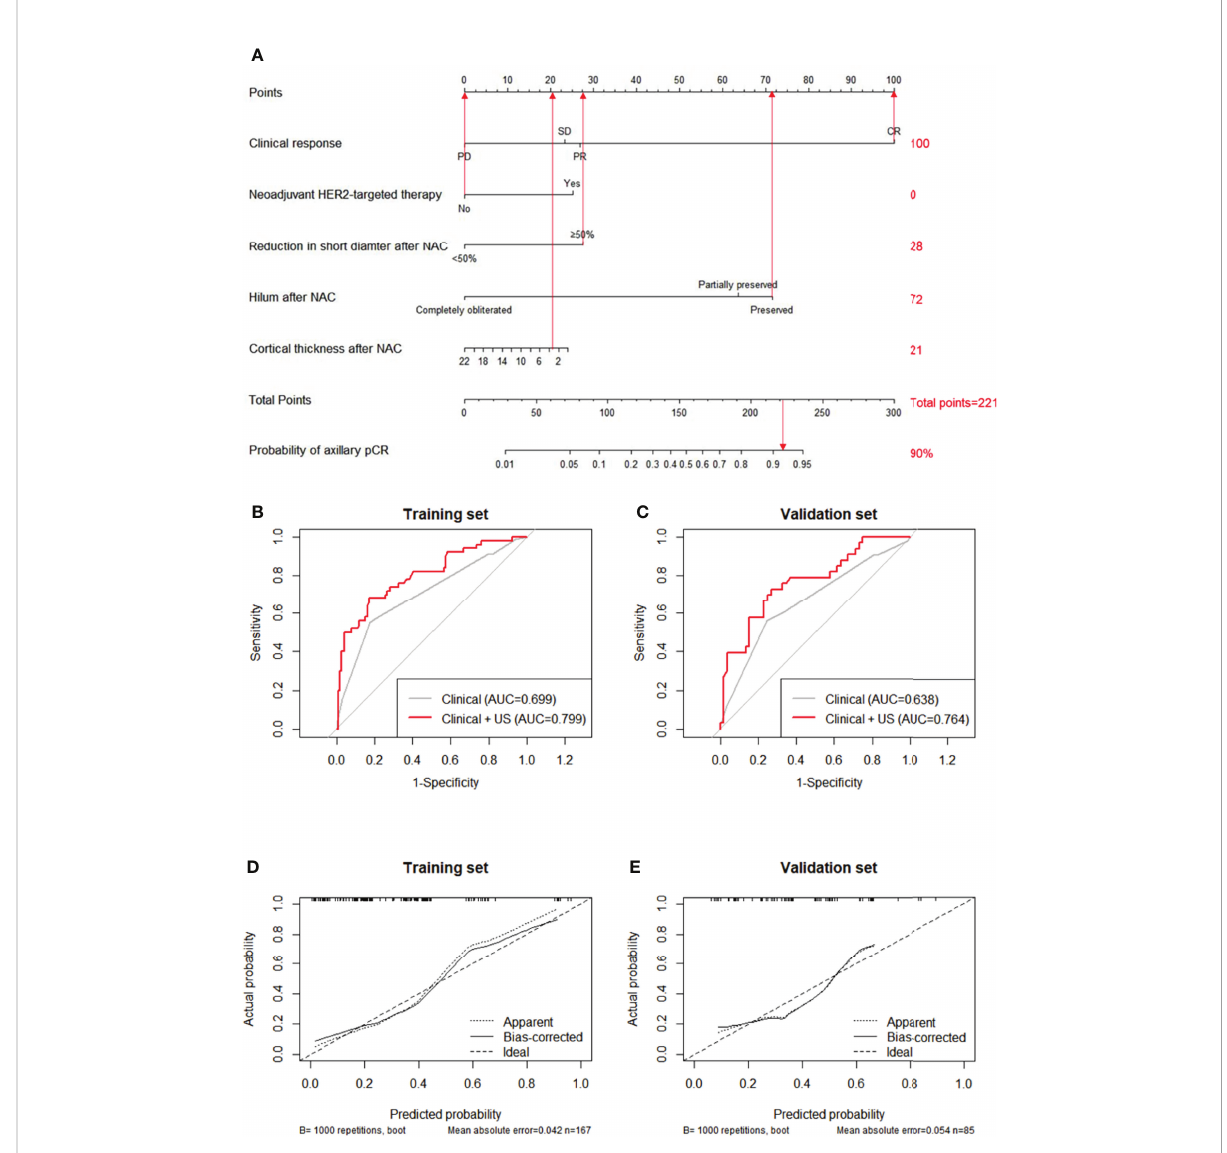
FIGURE 2 A nomogram for predicting the probability of axillary pCR (A) . Variables including neoadjuvant HER2-targeted therapy, clinical response, reduction in short diameter after NAC, hilum after NAC, and cortical thickness after NAC were assigned with points value. A total point added with these variables ’ points indicated the probability of axillary pCR. The vertical lines between fi ve variables and the fi rst row can be added as a total point, the probability of axillary pCR can be fi nally obtained by drawing a vertical line between total points and the fi nal row. Receiver operating characteristic curves (ROCs) of the clinical features and both clinical and US features for the prediction model in the training set (B) , P =0.001) and in the validation set (C) , P =0.027). Calibration curve of the nomogram predicting axillary pCR after neoadjuvant chemotherapy of the training set (D) and the validation set (E)